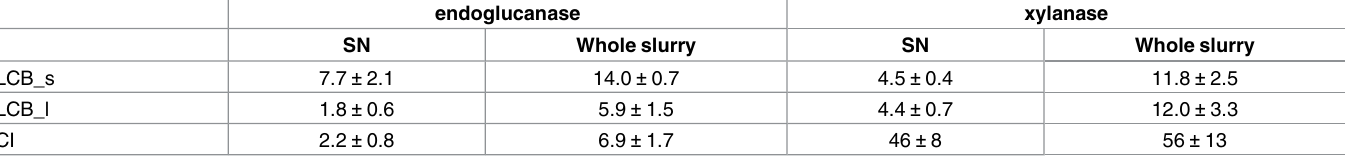
Table 2. Endoglucanase and xylanaseactivities (nmol min -1 ml -1 ) of initial compost sample and enrichments.